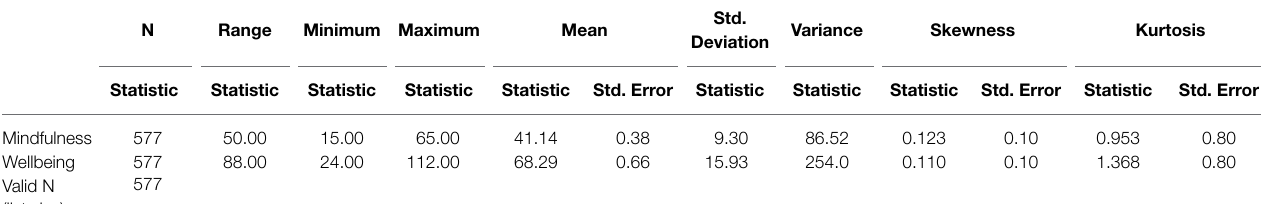
TABLE 2 | The results of descriptive statistics for the mindfulness and wellbeing questionnaires. N Range Minimum Maximum Mean